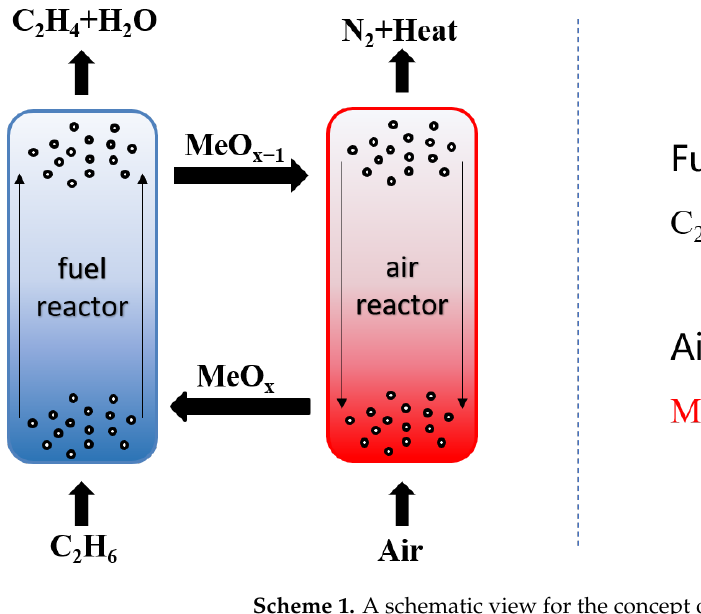
Scheme 1. A schematic view for the concept of ethane